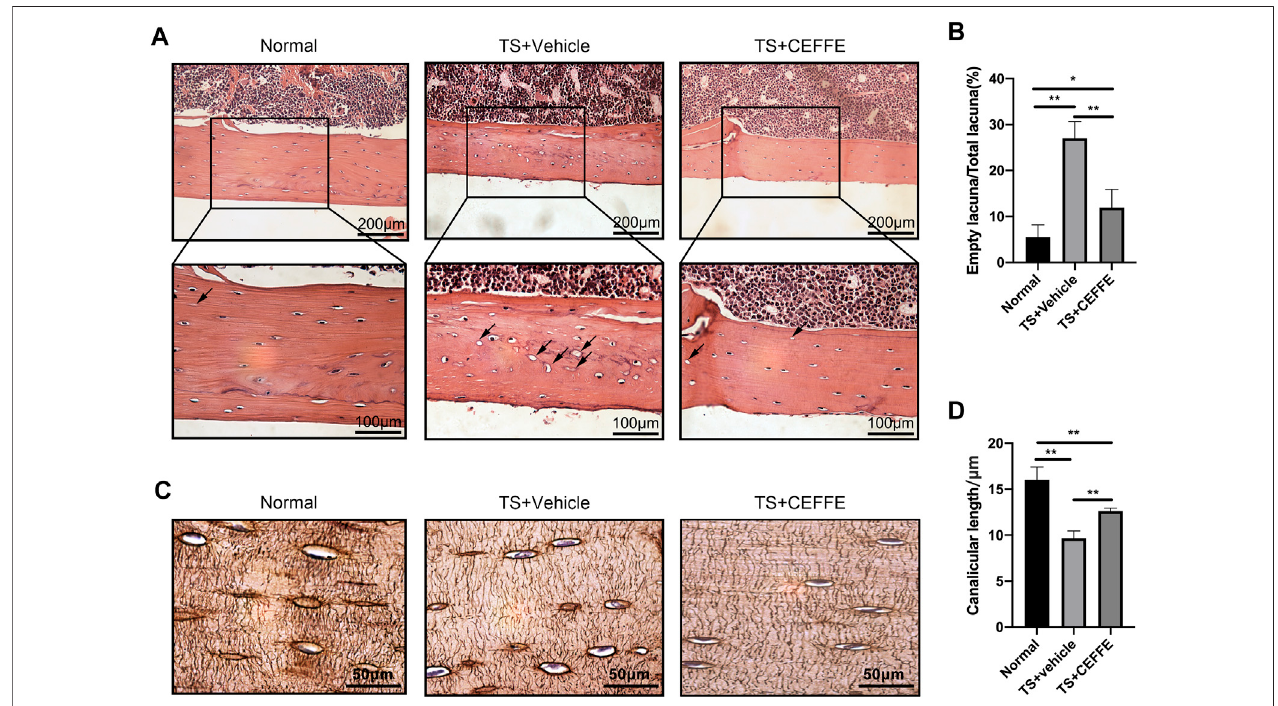
FIGURE 2 | CEFFE improved the lacunocanalicular microstructure in tail-suspended mice. Representative pictures of H&E staining in the femurs (A) and quanti fi cation of empty bone lacunae (B) . Representative pictures of silver staining in the femurs (C) and quanti fi cation of empty bone lacunae (D) . * p < 0.05, ** p <